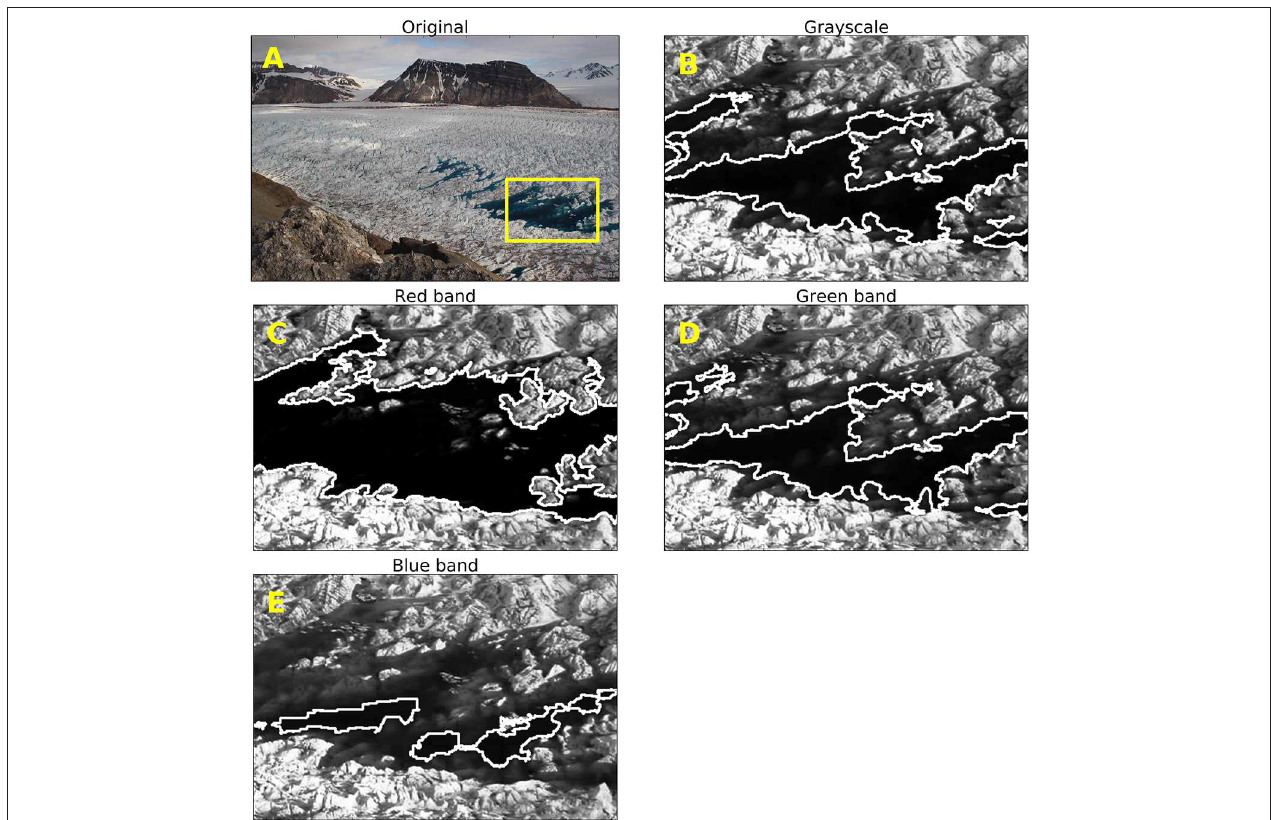
FIGURE 4 | An example of PyTrx’s ability to the extract pixel information from a specified image band using an example image from Kronebreen. The image shows a cluster of supraglacial lakes, which were monitored through the 2015 melt season. (A) shows the original time-lapse image. The yellow box denotes the subset from which pixel information is extracted from and displayed in the subsequent images: grayscale (B) , the red image band (C) , the green image band (D) , and the blue image band (E) . The white plotted lines in these subsets show attempts to automatically detect the lake extent. The red image band yields the best detection as it closely follows the lake